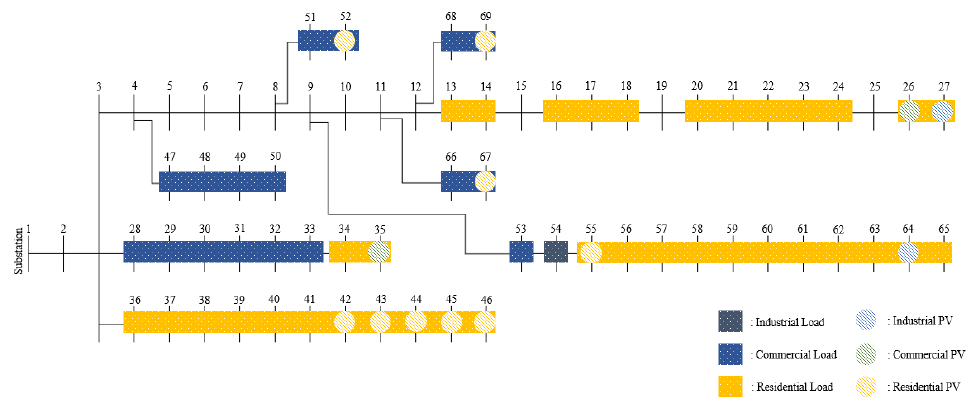
Figure 3. IEEE 69-bus distribution system.